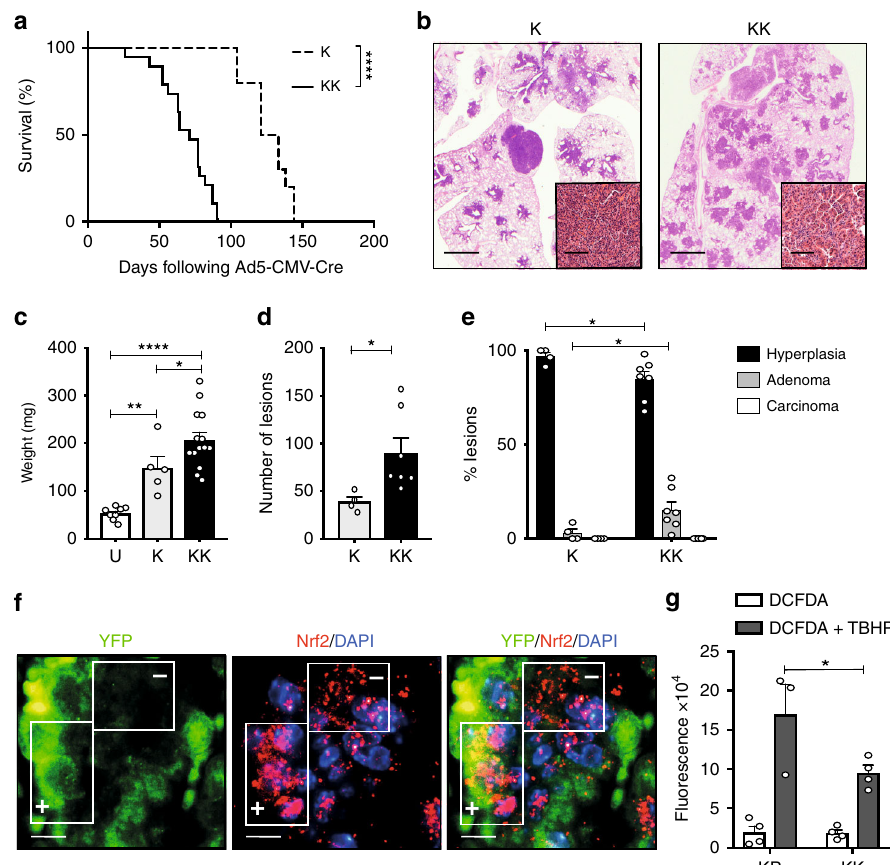
Fig. 2 Keap1 inactivation accelerates Kras G12D -induced lung adenocarcinoma. a Survival analysis of K ( n = 10) and KK ( n = 19) mice following Ad5-CMV-Cre administration. Mantel-Cox test: **** p <0.0001. b Hematoxylin and eosin (H&E) stained lungs of representative K and KK mice at ethical endpoint. Scale,